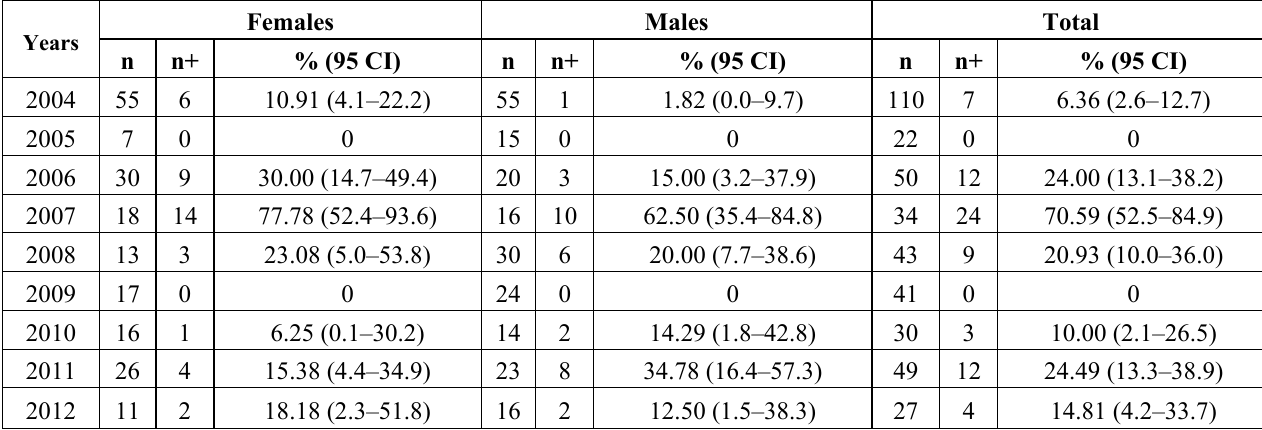
Figure 2. Evolution of percentage of EBLV-1 seropositive bats by species from 2004 to 2012. Black circles for P. austriacus , grey circles for T. teniotis and black triangles for other species ( E. serotinus , E.s; H. savii , H.s, P. kuhlii , P.k; and P. pipistrellus , P.p). Table 3. The number of bat samples analyzed during the nine-year